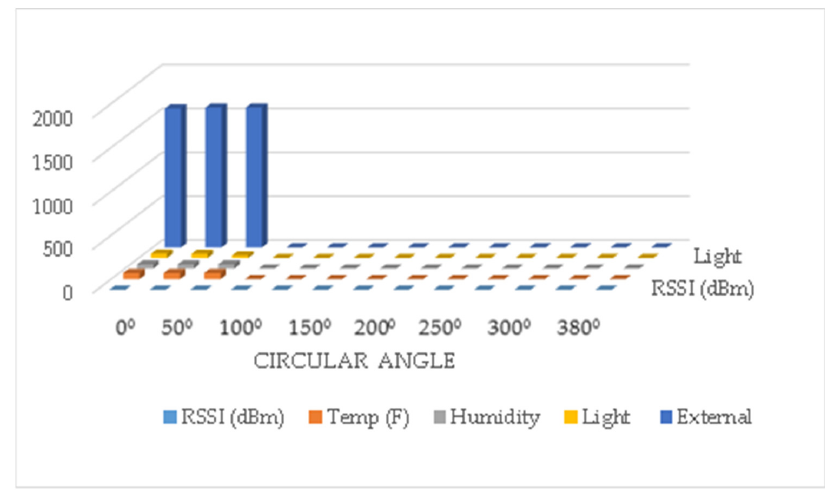
Figure 9. 150° Sense Data from Patch Antenna.